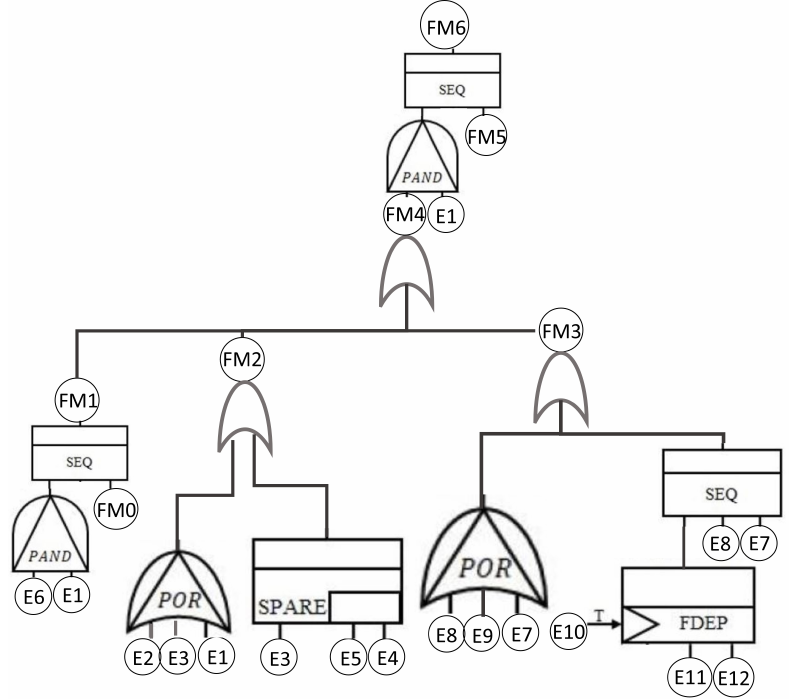
Figure 12. Dynamic Fault